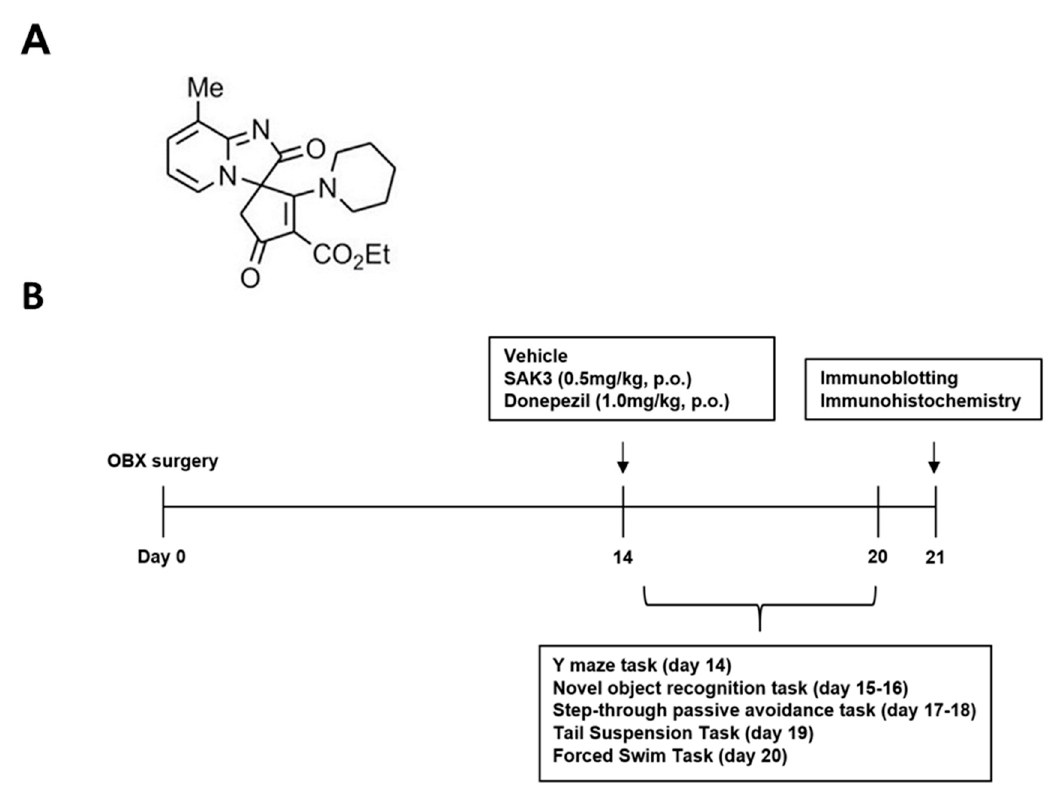
Figure 5. Experimental protocol for this study: ( A ) chemical structure of SAK3; ( B ) Experimental schedule for the present study. From day 14, 8-month-old ddY sham and OBX mice were subjected to a behavioral task 30 min after vehicle, SAK3 (0.5 mg/kg, p.o.) or Donepezil (1.0 mg/kg, p.o.) administration. After finishing the behavioral task, mice were sacrificed and their brains were removed for use in various experiments.